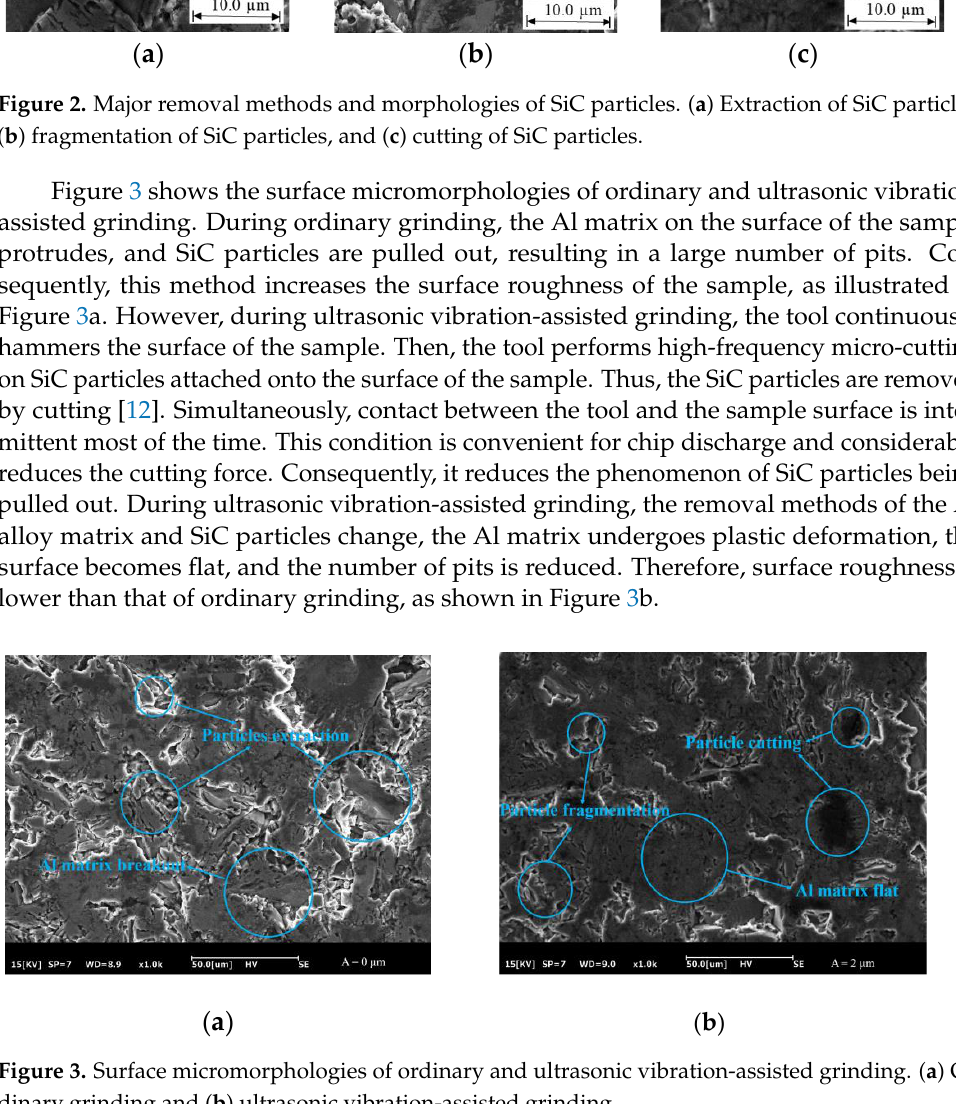
( b ) Figure 4. 3D topography of SiCp/Al: ( a ) ordinary grinding and ( b ) ultrasonic vibration-assisted grinding.